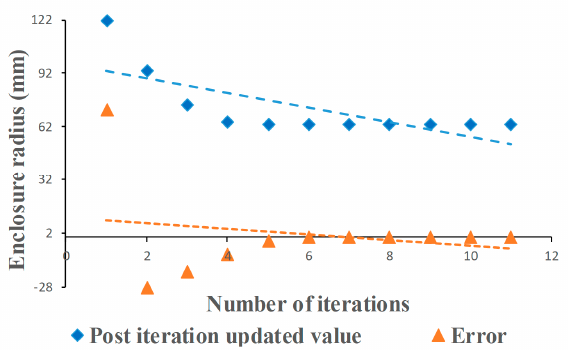
Figure 16. Optimized enclosure dimension regarding the permissible field utilization factor (FUF).